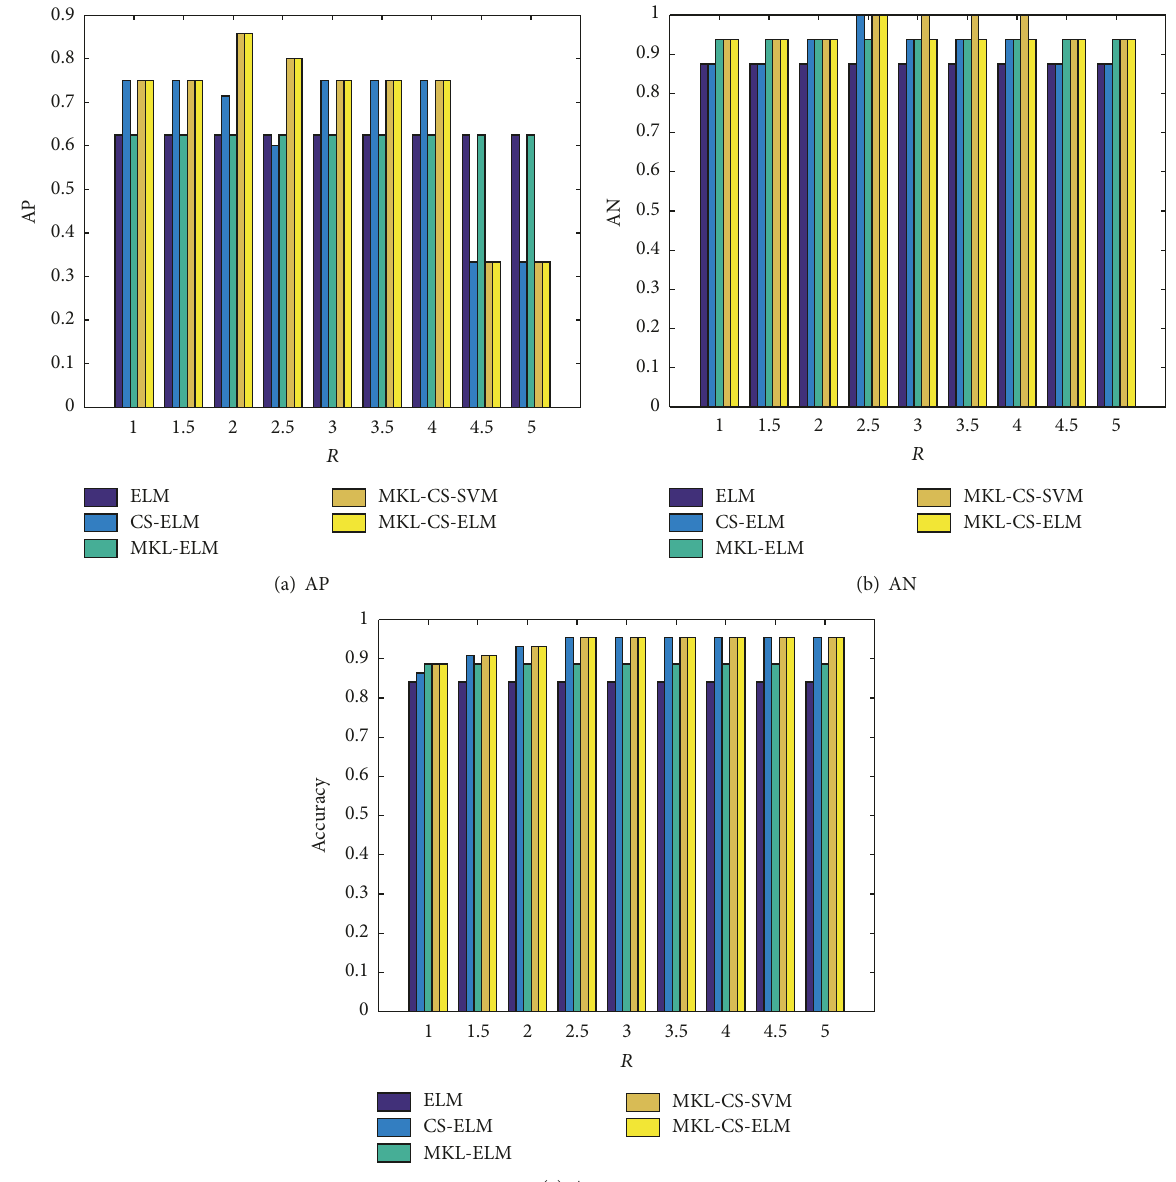
Figure 10: The recognition results of five classification models in